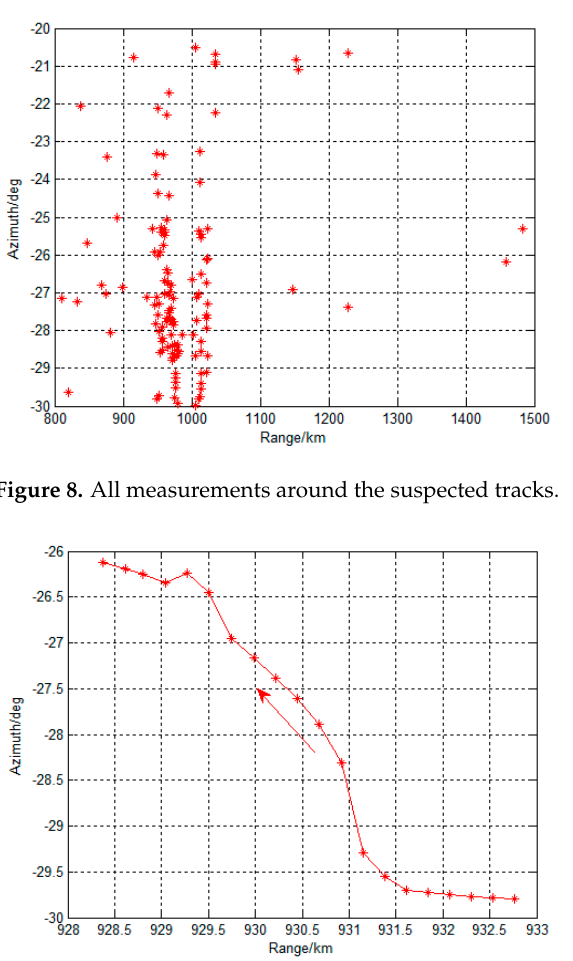
Figure 9. Tracking result of actual data collected in Weihai, China.